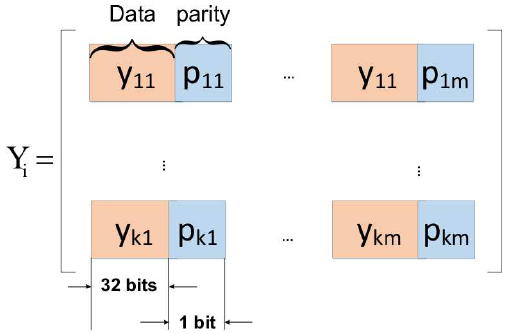
Figure 5. Adding parity bits to projection data Y i .